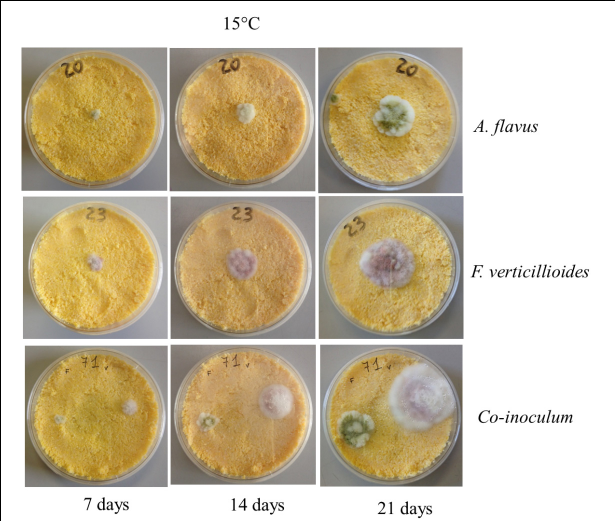
FIGURE 2 | Example of Aspergillus flavus ( Af ) and Fusarium verticillioides ( Fv ) growth with alone colonies and together colonies on corn meal medium (CMM) incubated at 15 ◦ C for 7, 14, and 21 days.